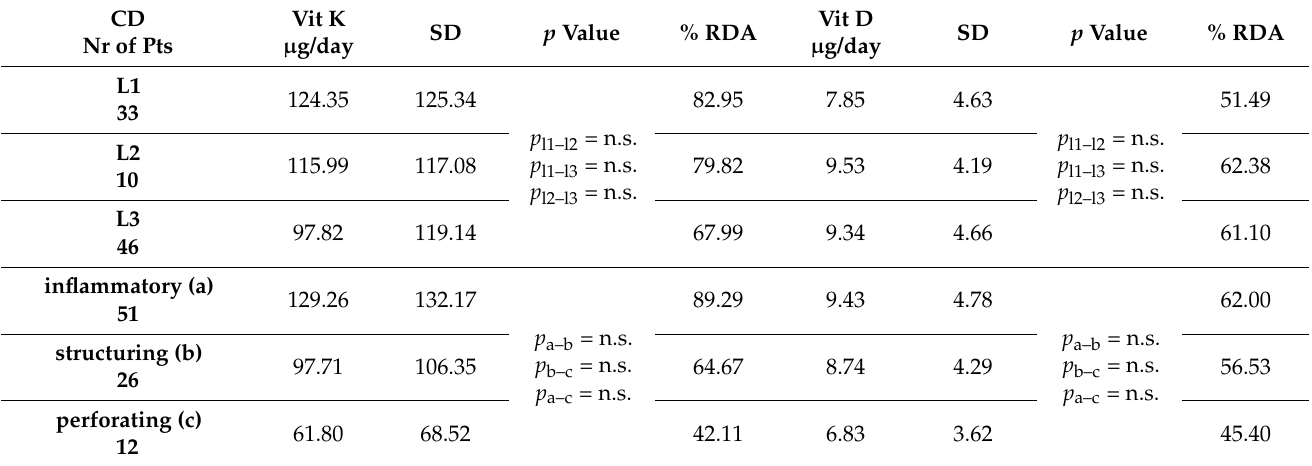
Table 4. Vitamin K and D intake, in Crohn’s Disease, in relation to disease location and behavior.